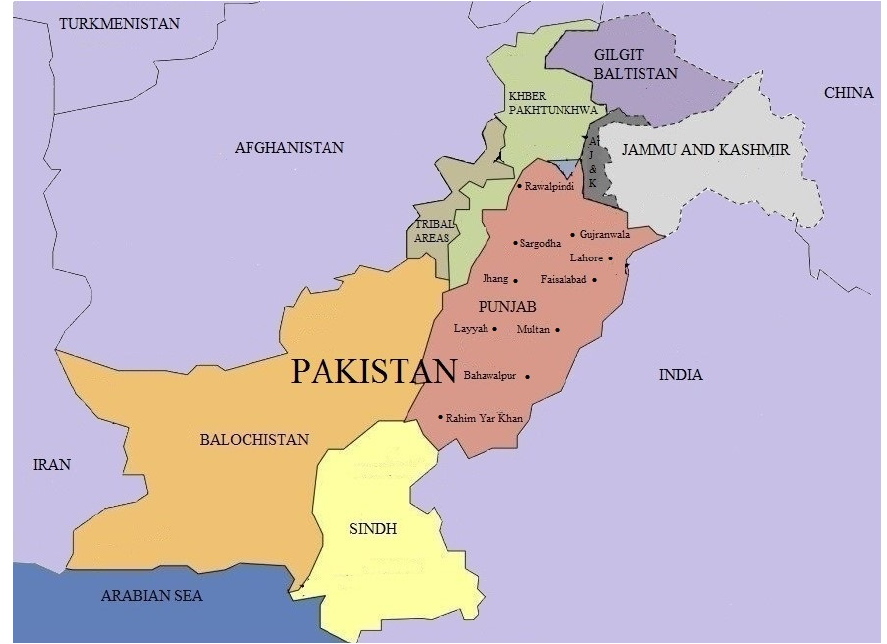
Figure 1. Map of Pakistan showing the regions of origin for the ten sampled populations of Rhyzopertha dominica, Sitophilus granarius, Tribolium castaneum and Trogoderma granarium tested for phosphine resistance.